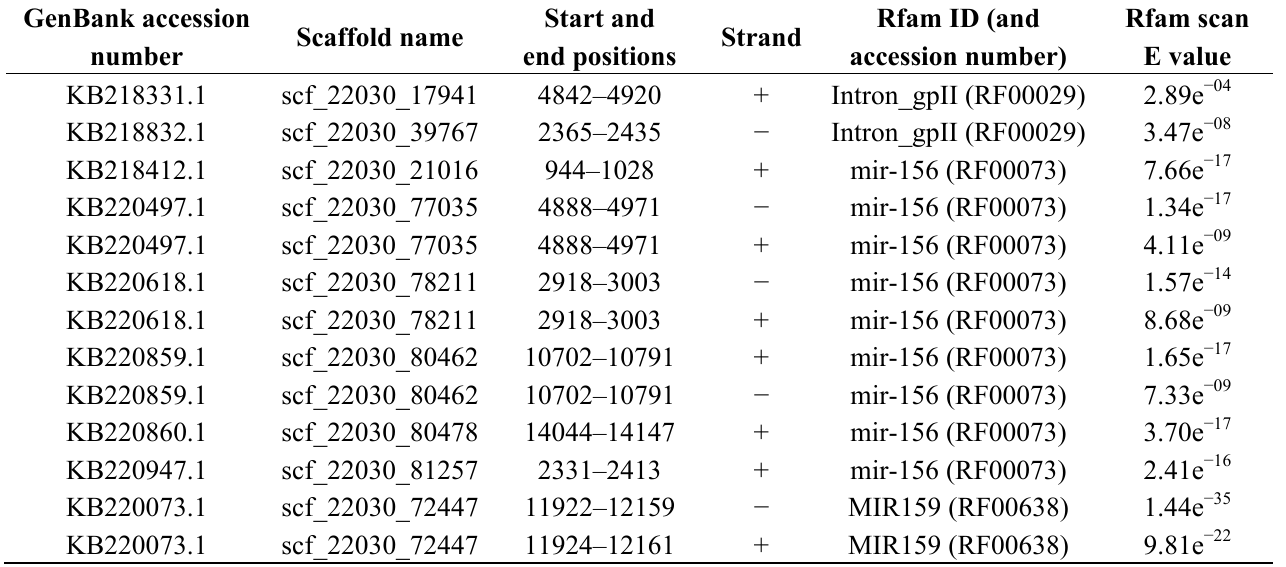
Table 3. Predicted non-coding RNAs in the enset genome assembly predicted by Rfam version